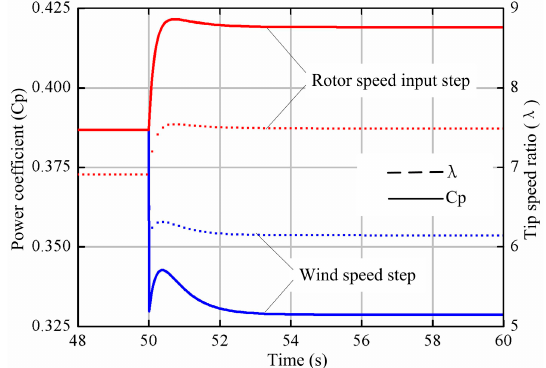
Figure 14. Power coefficient and tip speed ratio.